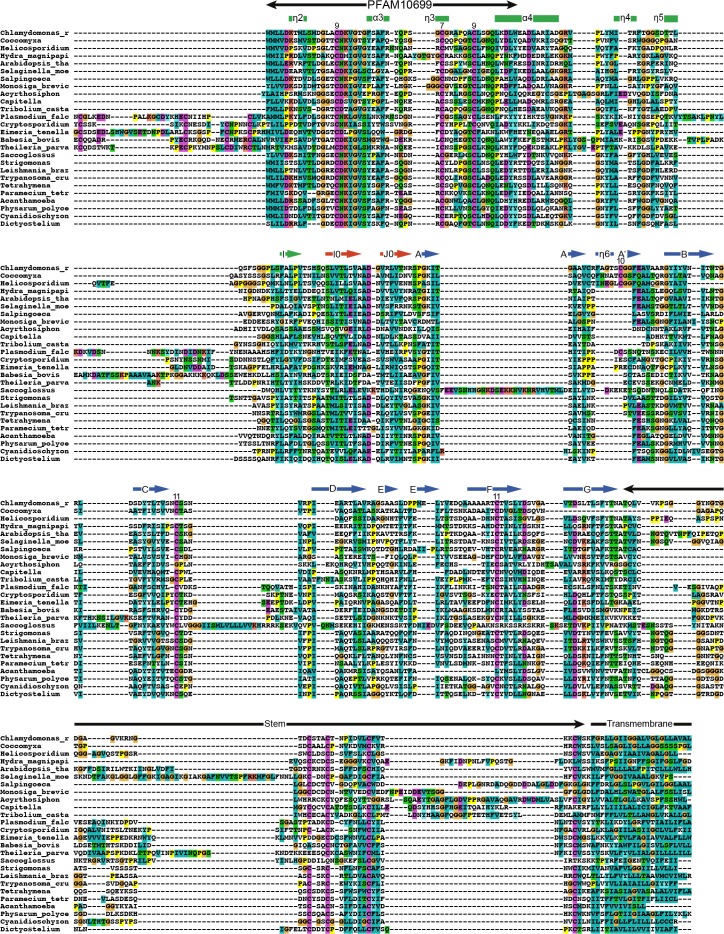
See legend for Figure 3—figure supplement 1.